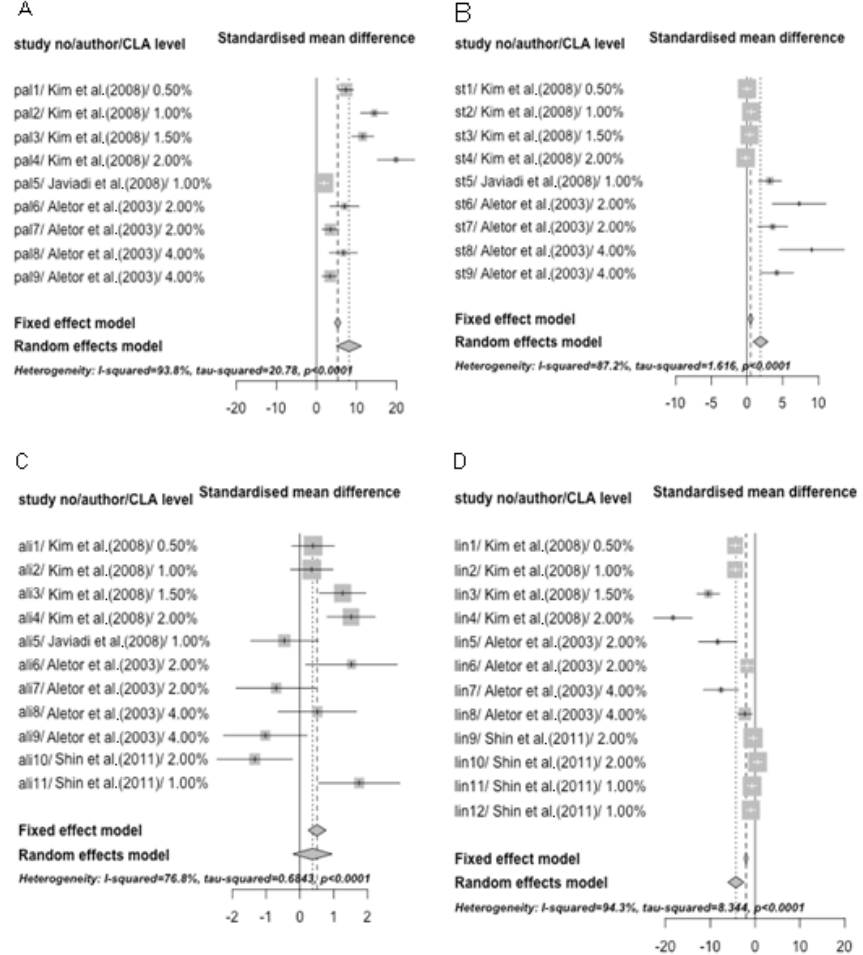
Figure 3. Forest plots for the effect of CLA feeding on fatty acid profiles in thigh meat of broiler chicken. (A) palmitic acid, (B) stearic acid, (C) C18:3, (D)